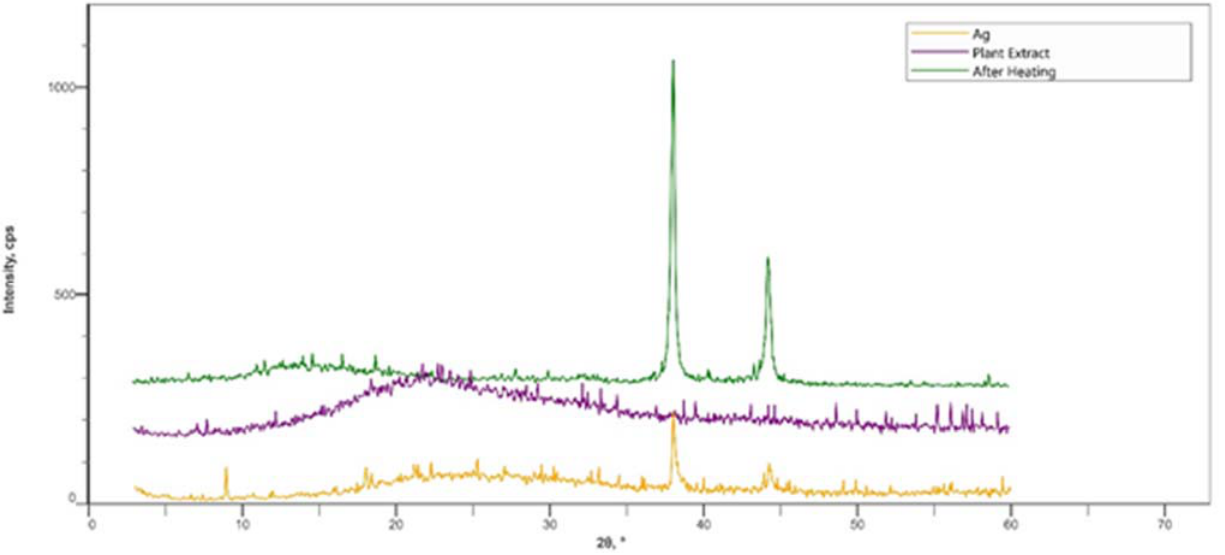
Figure 4. XRD patterns for random orientation powder of green synthesized AgNPs and dry powder of Ethanolic plant extract [(Ag): Synthesized AgNPs using Ethanol plant extract (AgEPE) at 30 ◦ C, (After Heating): calcined Synthesized AgEPE at 250 ◦ C, and (Plant extract): Ethanolic plant extract at 30 °C], * in x ‐ axis stands for degree.